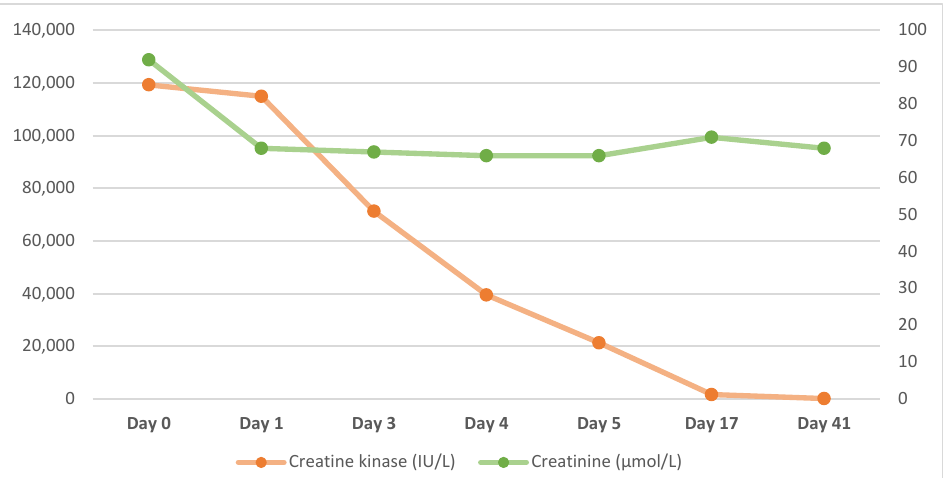
Figure 1. Creatine kinase (left axis) and creatinine levels (right axis) during admission and at follow up.